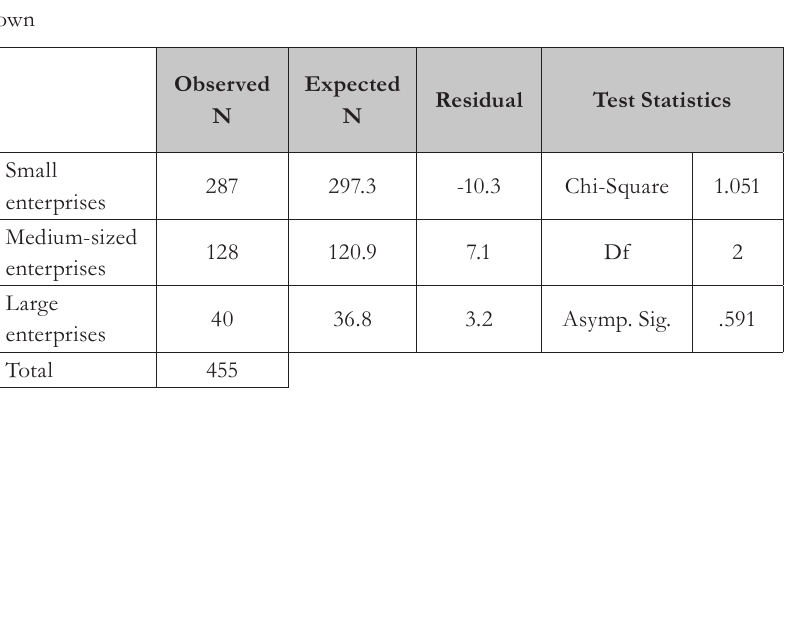
Tab. 2 - Verification of representativeness of the survey sample by size of enterprise.